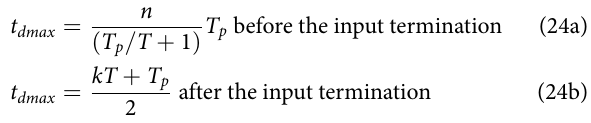
Frontiers in Built Environment |